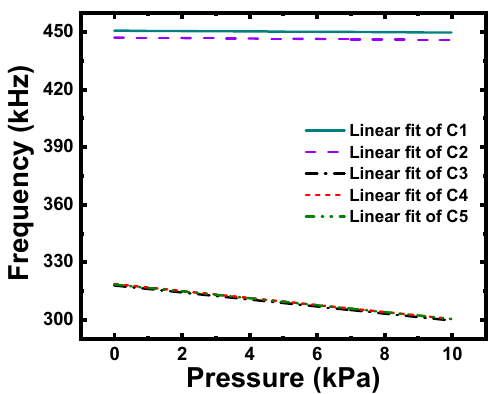
Figure 12. Resonance frequency of C1–C5 under pressures of 0–10 kPa. Table 7. Pressure sensitivity, linear fit, and enhancement of